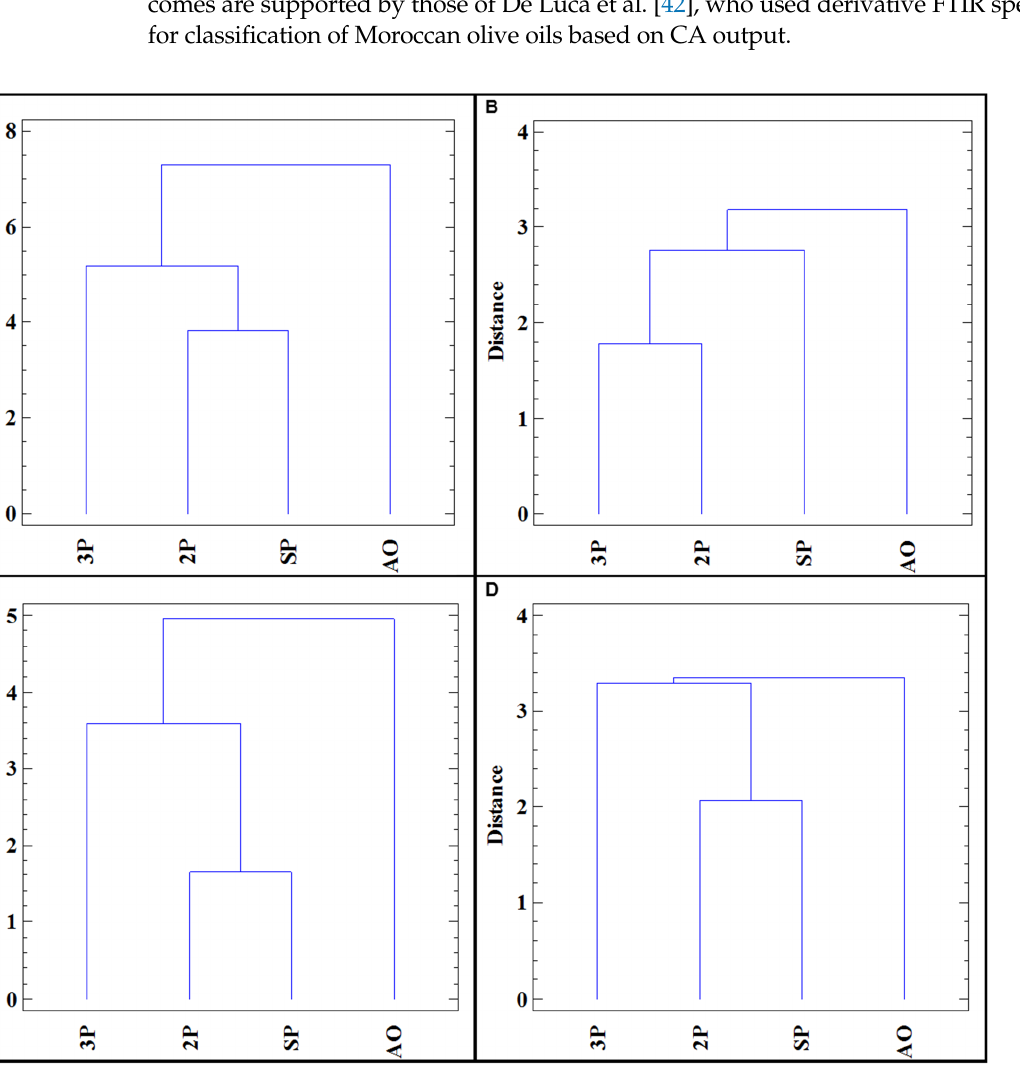
Figure 4. Dendrogram performed based on Euclidean distance in studied almond genotypes. ( A ) = dependent variables are all studied parameters, ( B ) = based quality indices (AV, PV, humidity, K232, and K270), ( C ) = fatty acids, and ( D ) = sterols.